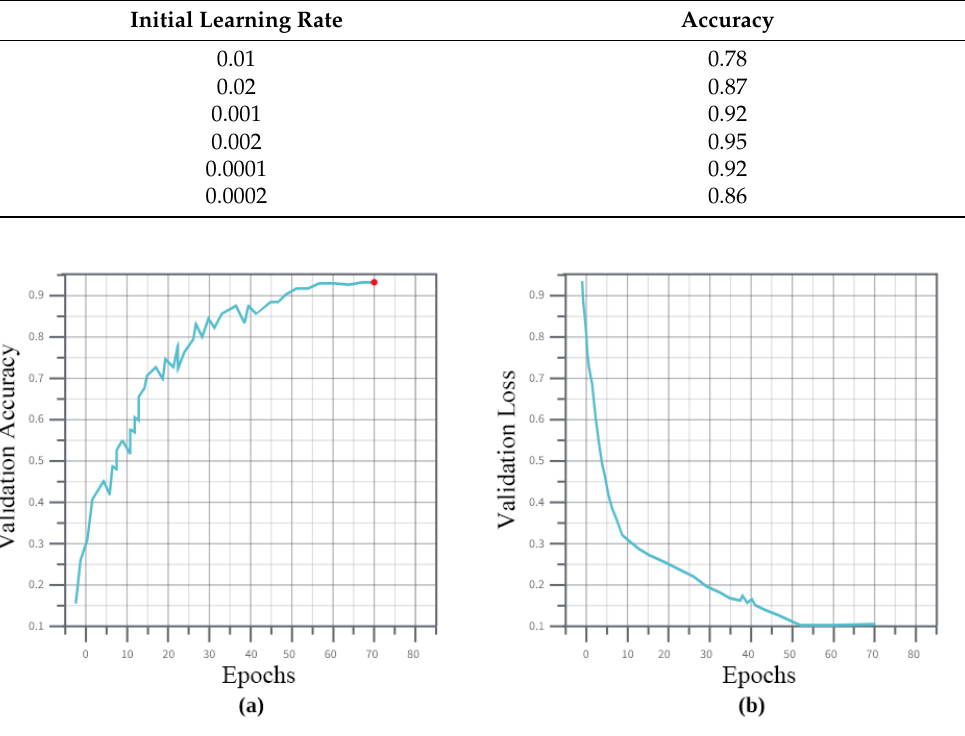
Figure 11. Impact of the fine tuning on the model. ( a , b ) show the accuracy and loss evolution during training on the validation set for a fixed epochs of 70 and 0.002 learning